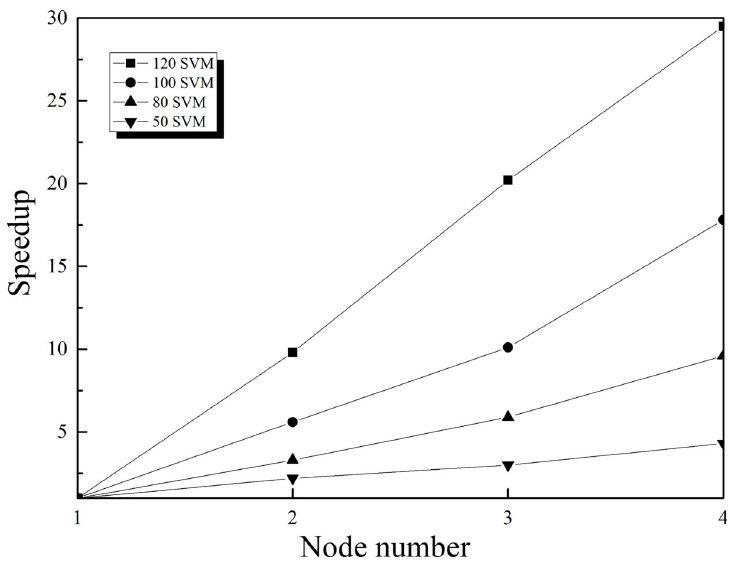
Fig 5. Comparison of the speedup